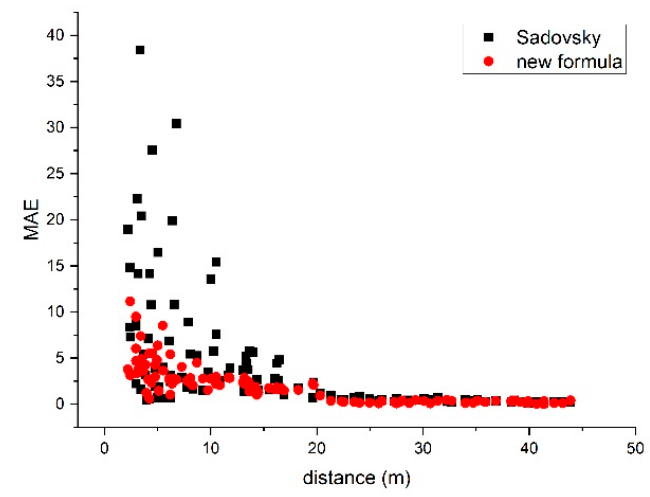
Figure 8. Relationship between mean absolute error and distance.